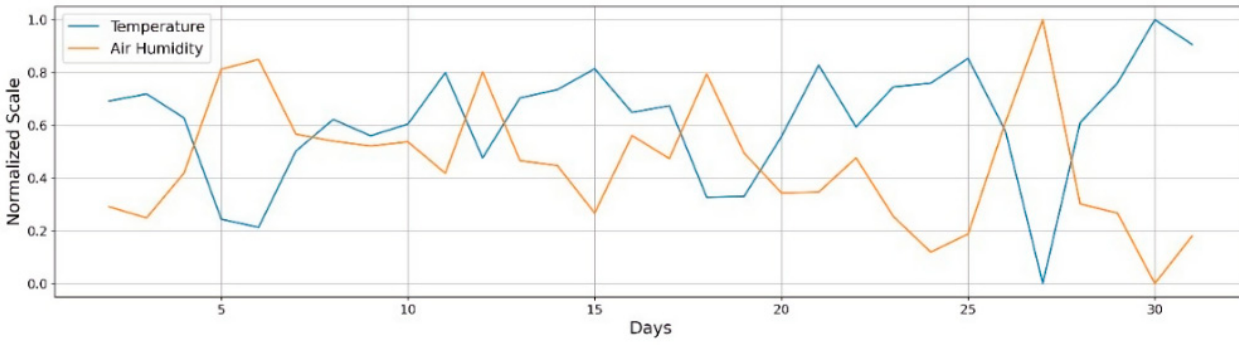
Figure 7. Temperature and air humidity in 30 days.